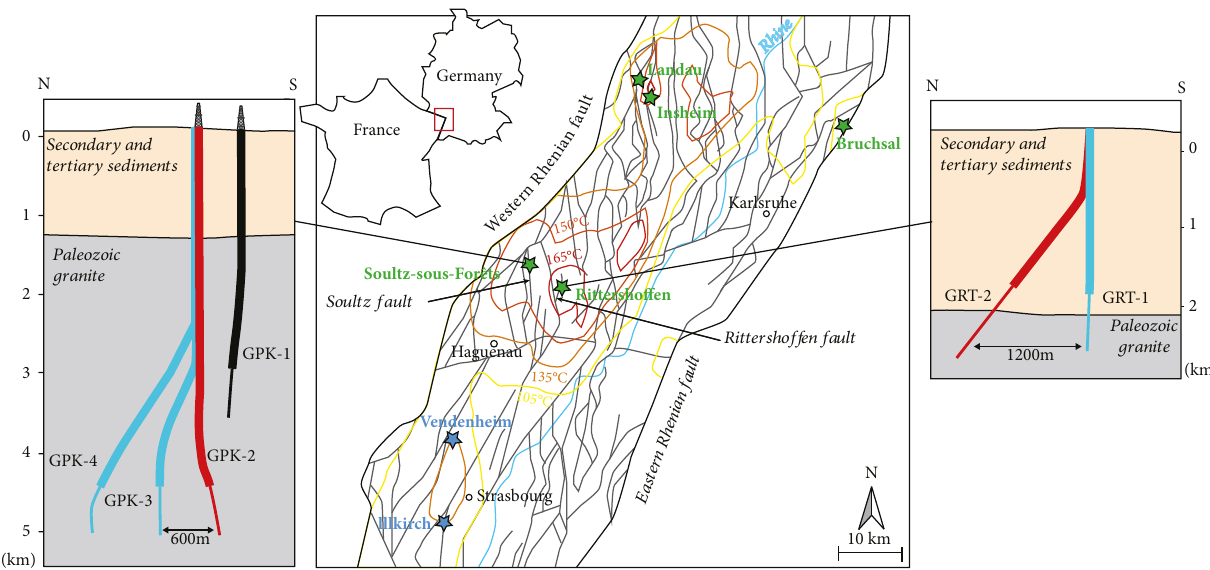
Figure 1: Structural map of the center of the Upper Rhine Graben with isotherms at a 2km depth from the geoportal GeORG [55]. The geothermal anomaly in the Strasbourg area is from the dataset of Baillieux et al. [1]. Geothermal power plants in operation are represented by green stars, and the geothermal projects under drilling operations are represented by blue stars. On the left: N-S section through the geothermal wells of the Soultz-sous-Forêts power plant with a simpli fi ed geology. On the right: N-S section through the geothermal wells of the Rittersho ff en power plant with a simpli fi ed geology. The thick line represents the casing section of the well, whereas the thin one represents the open hole. Production wells are in red, and injection wells are in blue. The GPK-1 well is represented in black because it is now used as an observation